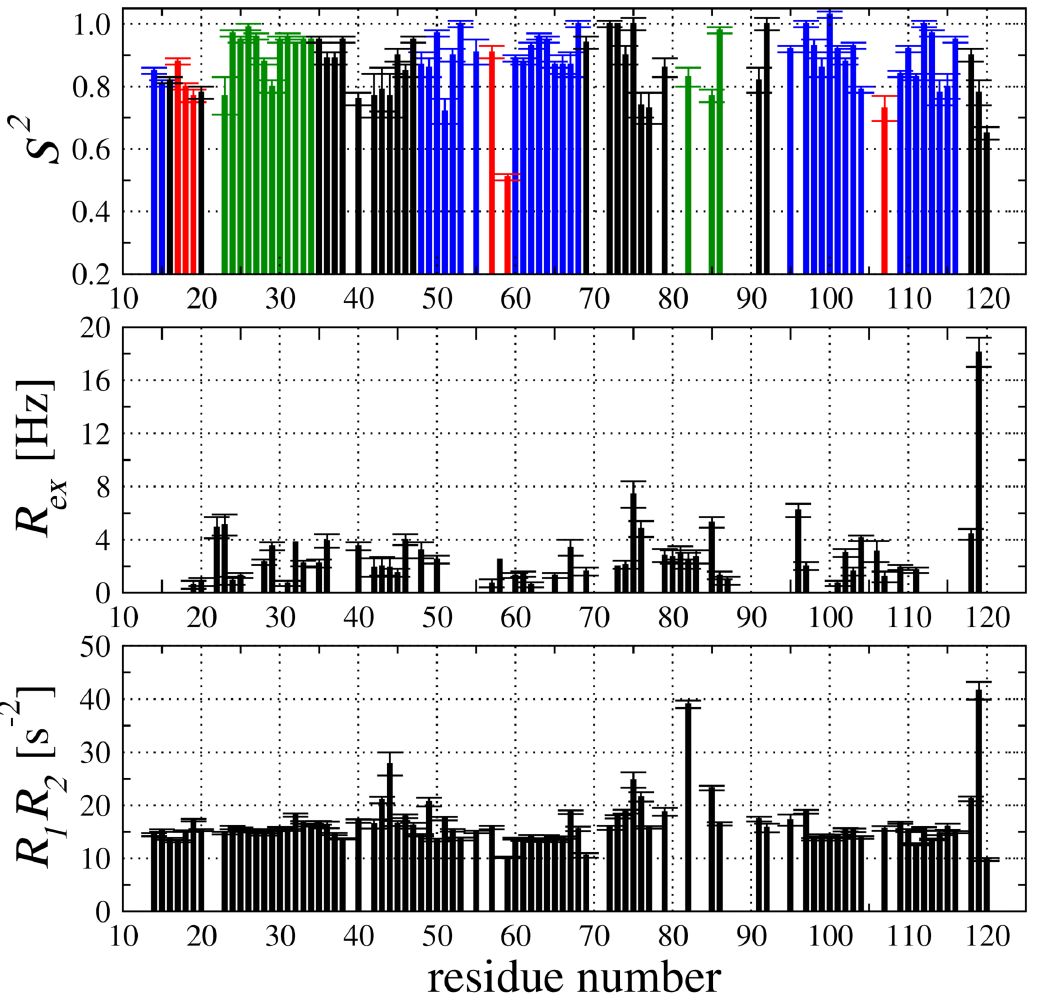
Figure 5. Model-free approach parameters: S 2 (top), R ex (middle), and R 1 R 2 product (bottom). The S 2 parameter is high- lighted for the residues in different secondary structural elements as green ( α -helix), blue ( β -sheet), and red (flixible